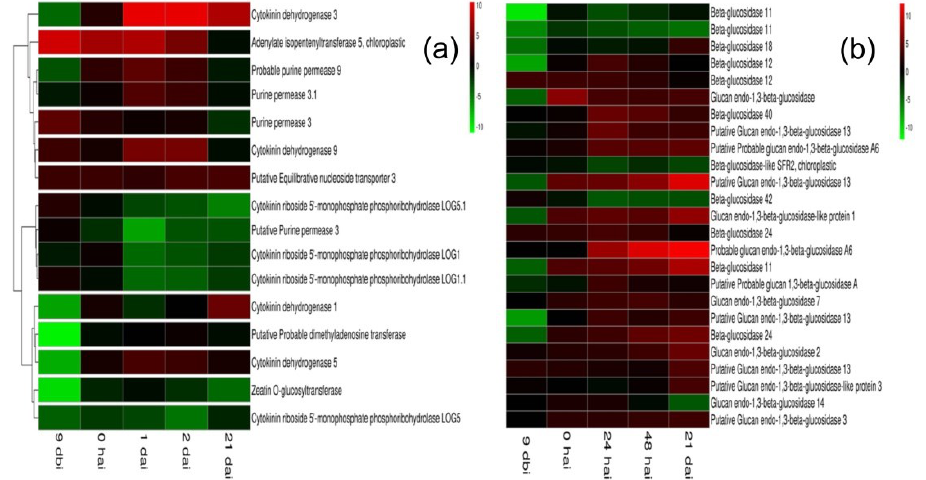
Figure 2. Expression profiles of genes involved in CK metabolism. The heatmap shows changes in transcript levels in different sampling points (-14 days vs. -9, 0, 1, 2, and 21 days). Gene names were annotated using Ugene and Blast2GO software: ( a ) members of CK homoestasis; ( b ) members of the β -glucosidase gene family and change in expression during SE of C. canephora . Hierarchical clustering was used to group genes with similar expression profiles. The red represents upregulated genes, and the green represents downregulated genes (log2 fold-change values).